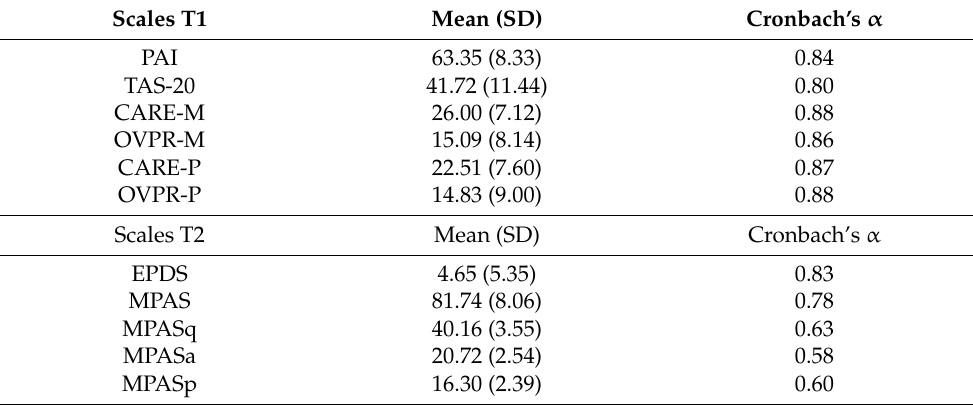
Table 3. Descriptive statistics of the questionnaires administered only at T1 or at T2 (N = 43).